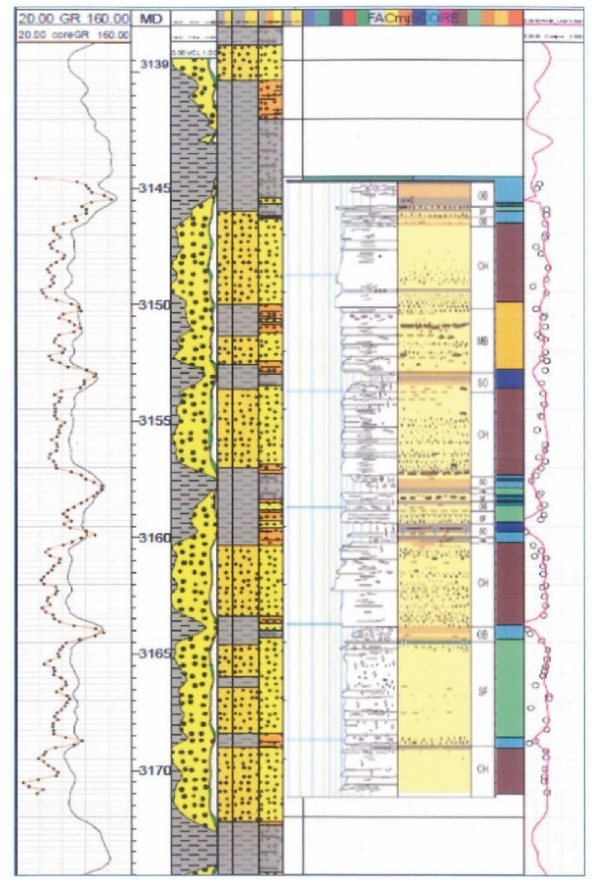
Fig. 4 Core analysis result of C reservoir in 4X (X-4X